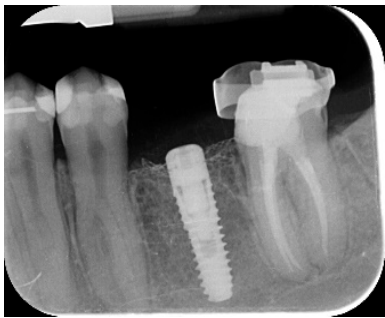
Figure 3. Radiographic view at implant placement.